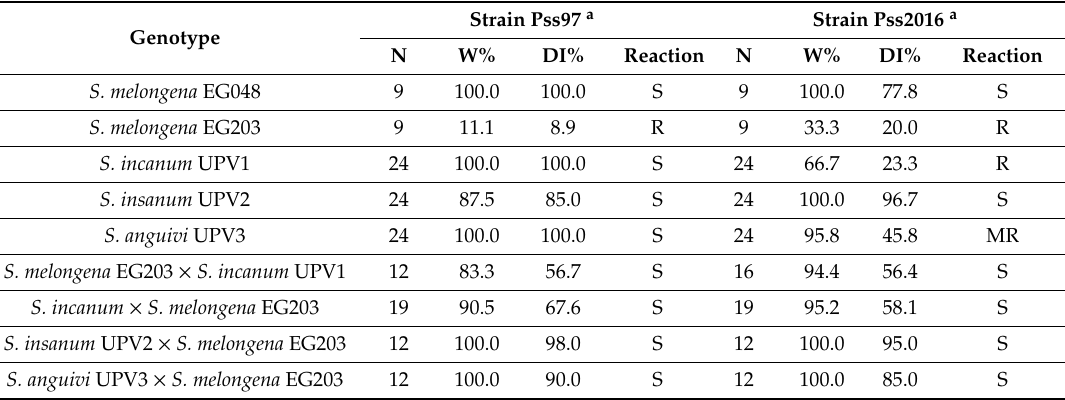
Table 4. Evaluation of a susceptible control of S. melongena (EG048), the parents of the